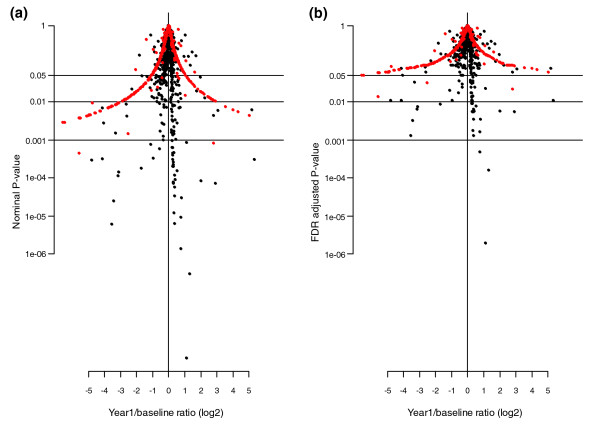
Volcano plots. (a) For nominal P-values. Relationship between the 1-year ET/baseline log2 ratios and their P-values. (b) For FDR adjusted P-values. Relationship between the 1 year ET/baseline log2 ratios and their FDR adjusted P-values.